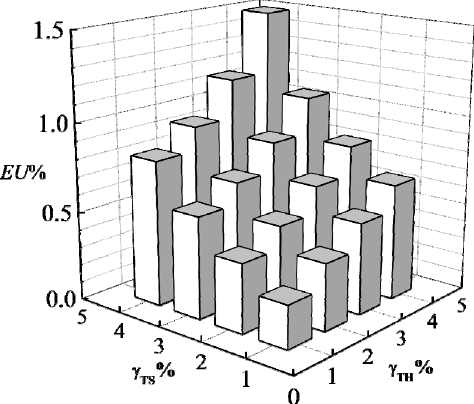
0.19, respectively, and the positions should have been the optimal sensor position for each